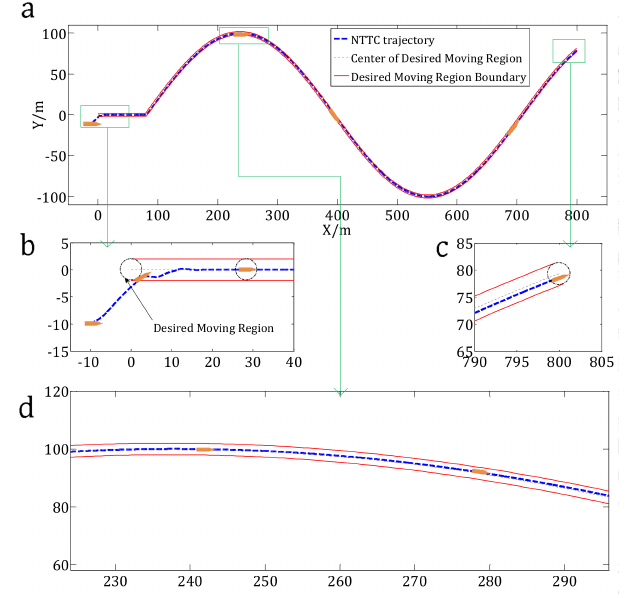
Figure 5. Results of the NTTC method. ( a ) Trajectory of the USV using the NTTC method; ( b ) Zoom view of the results from − 10 to 40 m in the X direction; ( c ) Zoom view of the results from 790 to 805 m in the X direction; ( d ) Zoom view of the results from 225 to 298 m in the X